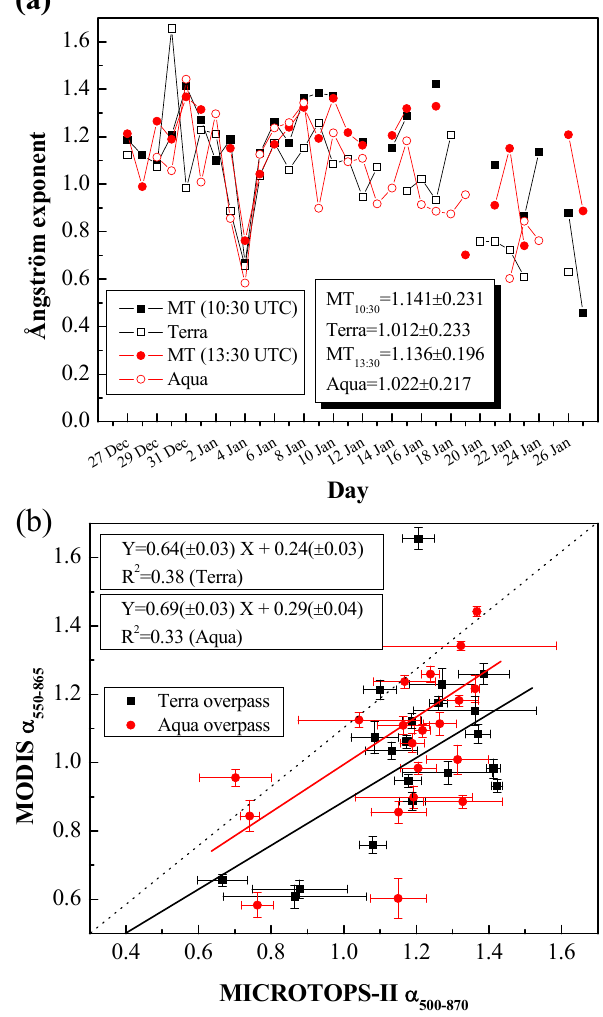
Fig. 13. Same remarks as in Fig. 12, but for the Angstrom